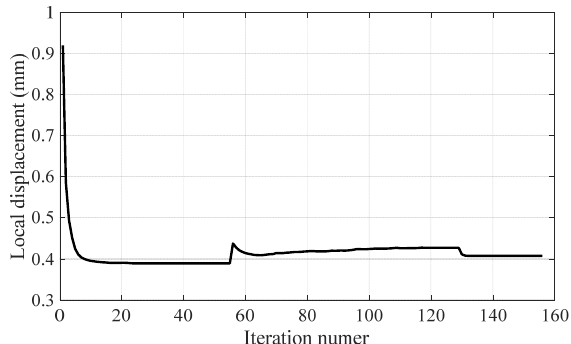
Figure 3. Iteration history for topology optimization of battery-hanging structure. Polymers 2020 , 12 , x FOR PEER REVIEW